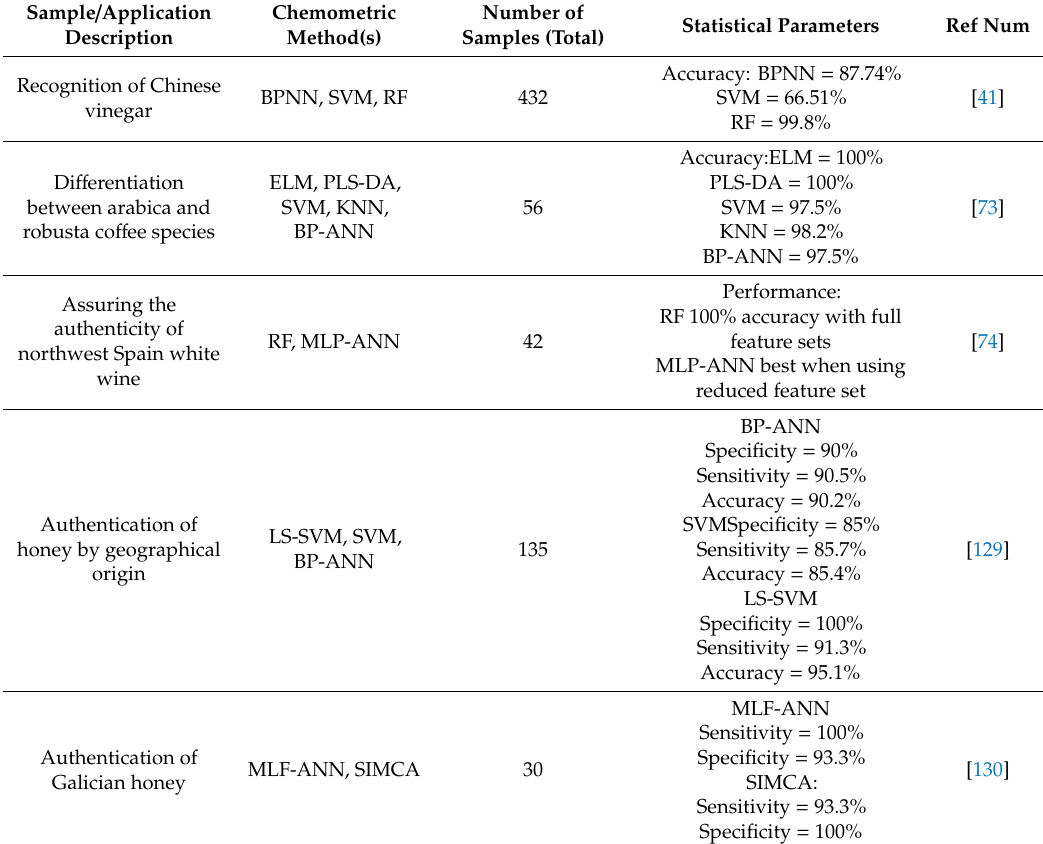
Table 7. Literature related to the use of chemometrics in classification of other food